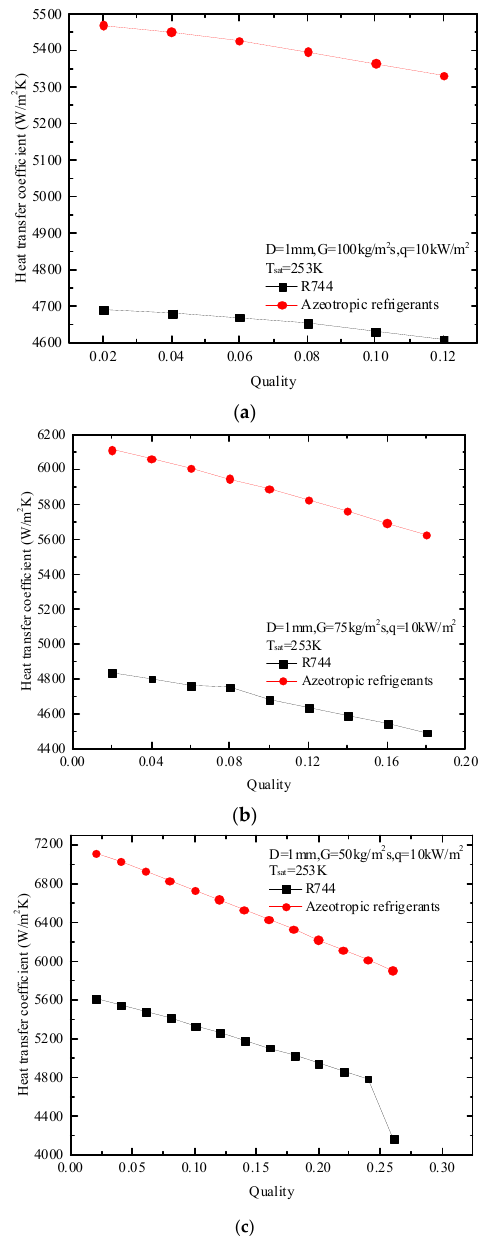
Figure 16. Comparison of heat transfer coefficients between azeotropic refrigerant and R744 at different mass fluxes: ( a ) G = 100 kg/m 2 s; ( b ) G = 75 kg/m 2 s; ( c ) G = 50 kg/m 2 s.